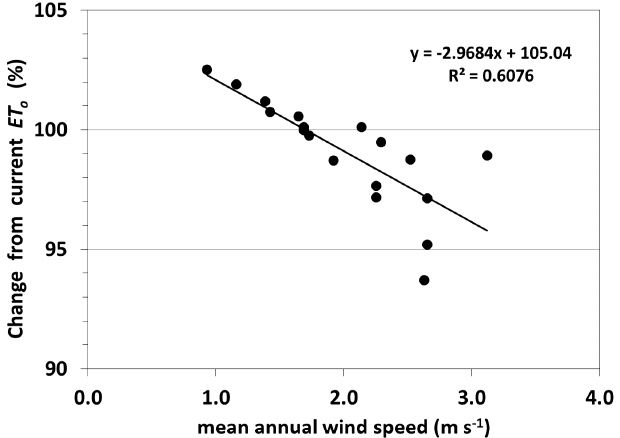
Figure 1. A plot of the change from current annual ET o (mm · y − 1 ) assuming T x increases by 2 ◦ C, T n increases by 4 ◦ C, T d increases by 4 ◦ C, and r c increases from 70 to 87 s · m − 1 versus the mean annual wind speed. Figure 1 is from Snyder et al.